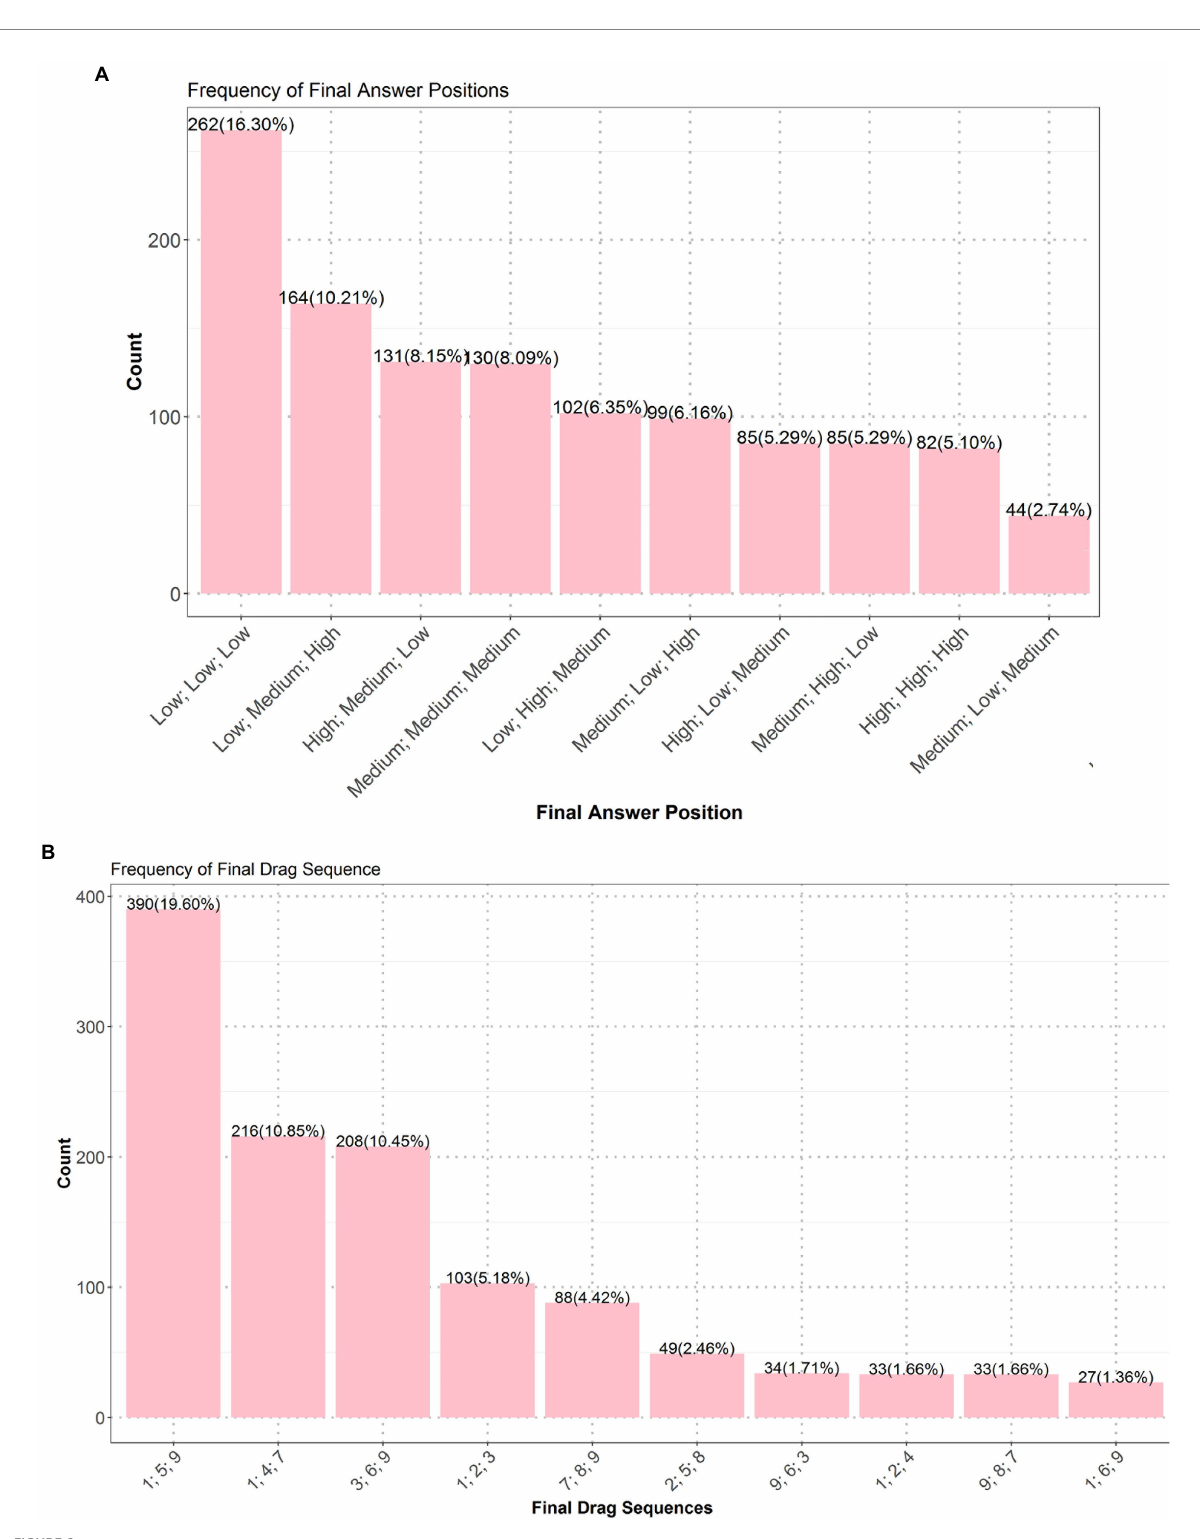
FIGURE 6 Top 10 frequent answers of the fair test 1 (A) and those of the fair test 2 (B) . Values on top of the bars are numbers of students, and those inside brackets are proportions.